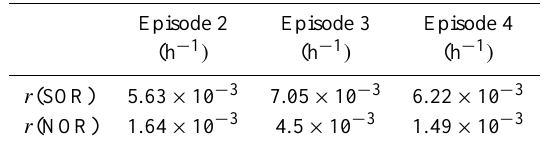
Table 3. The slopes of SOR and NOR during three haze